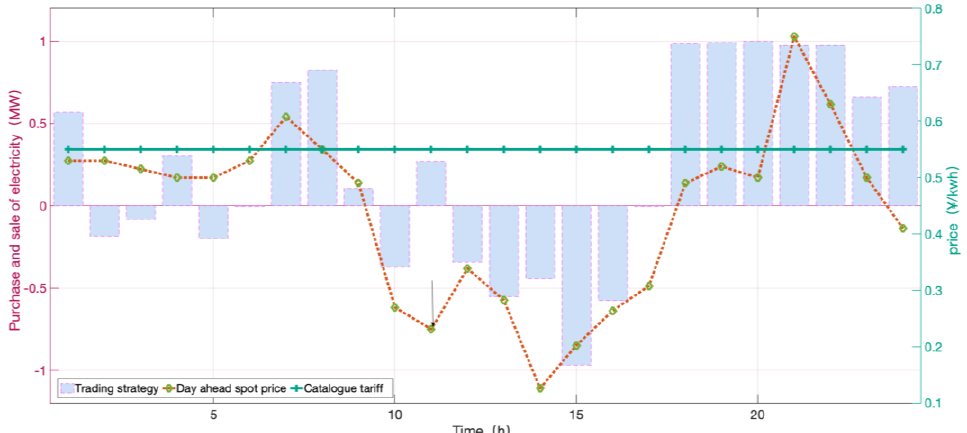
Figure 13. Robust bidding strategies of DERA considering psychological behavior.